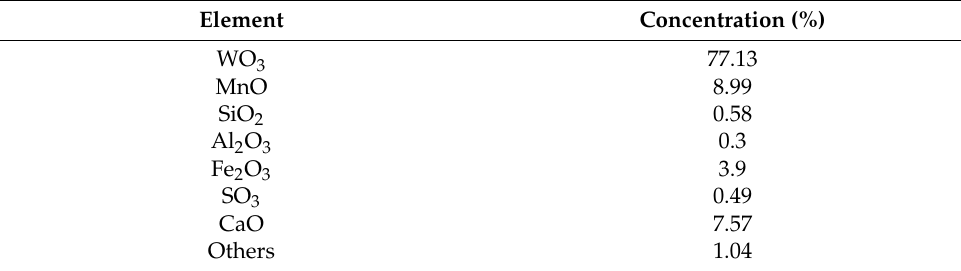
Figure 19. SEM-EDX and XRD analyses of wolframite sample. Table 5. Chemical compositions of wolframite